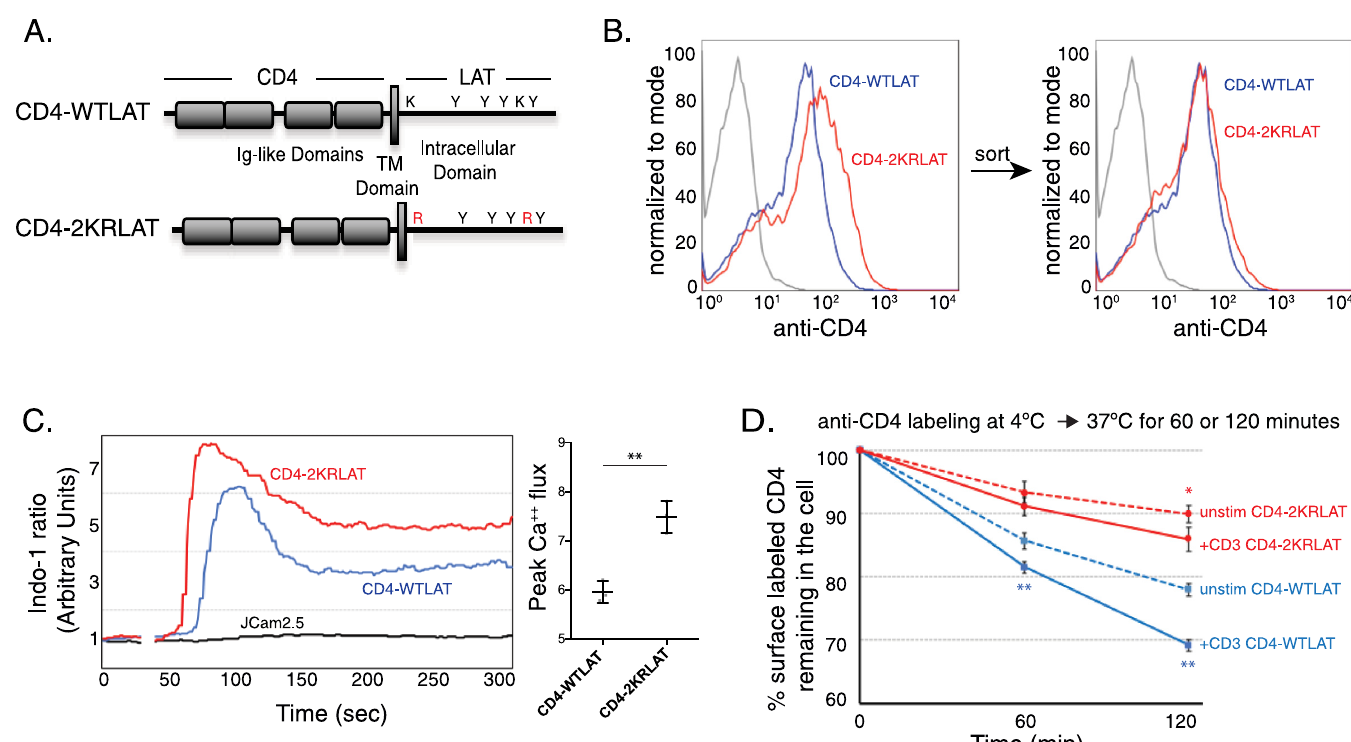
Fig 1. Characterization of CD4-2KRLAT. A . Schematic of CD4-WTLAT and CD4-2KRLAT chimeric constructs. B . Surface expression of CD4 in JCam2.5 cells stably expressing CD4-LAT and CD4-2KRLAT. C . JCam2.5 cells or cells stably transduced with CD4-LAT or CD4-2KRLAT were loaded with Indo-1 AM, stimulated with 10 μ g /ml OKT3 and assayed for intracellular calcium flux. Left: Representative plots of three independent experiments. Right: Quantitation of peak calcium flux measurements from three independent experiments. Each symbol denotes an individual experiment and bars denote means ± SD for each group. D . JCam2.5 cells stably expressing CD4-WTLAT or CD4-2KRLAT were labeled with anti-CD4 (clone OKT4) at 4˚C and transferred to 37˚C for indicated times at which total CD4 levels were measured by flow cytometry. % surface labeled CD4 remaining in the cell was measured as described in Materials and Methods. Bars denote means ± SEM of three independent experiments. Statistical significance was determine using Student’s t test. � p < 0.05; �� p < 0.0005.